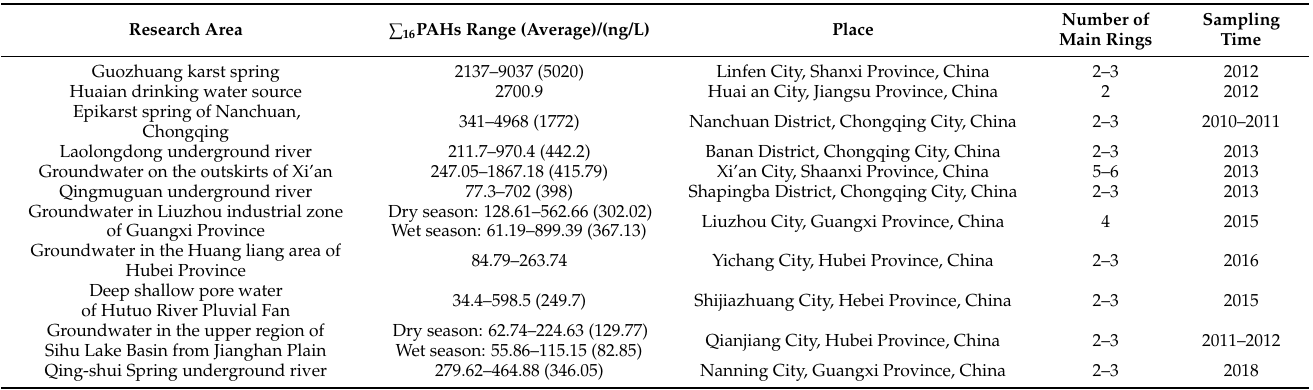
Table 3. Comparison of concentrations of ∑ 16 PAHs in groundwater from different research areas. Research Area